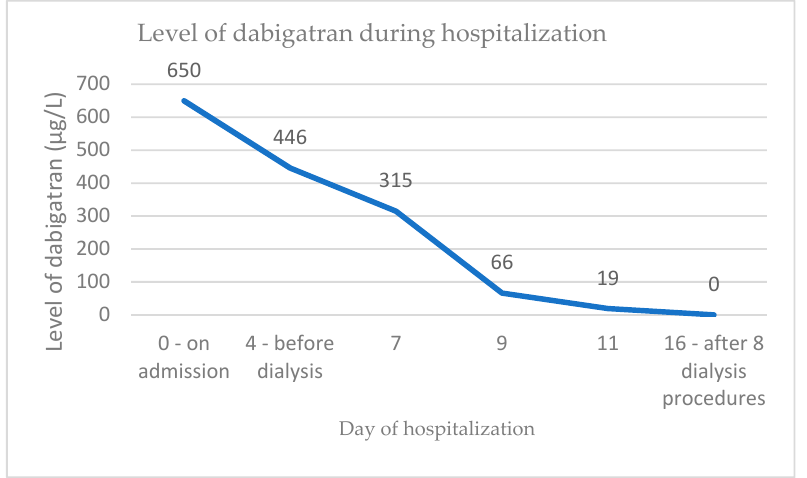
Figure 1. Level of dabigatran in the presented case during hospitalization. Common urological causes of macroscopic hematuria were ruled out. A kidney biopsy was performed after normalization of the coagulation times. It showed signs of ARN with occlusive intratubular RBC casts, diffuse acute tubular injury, and diffuse interstitial edema, together with mild IgA nephropathy (IgAN) (Figure 2).